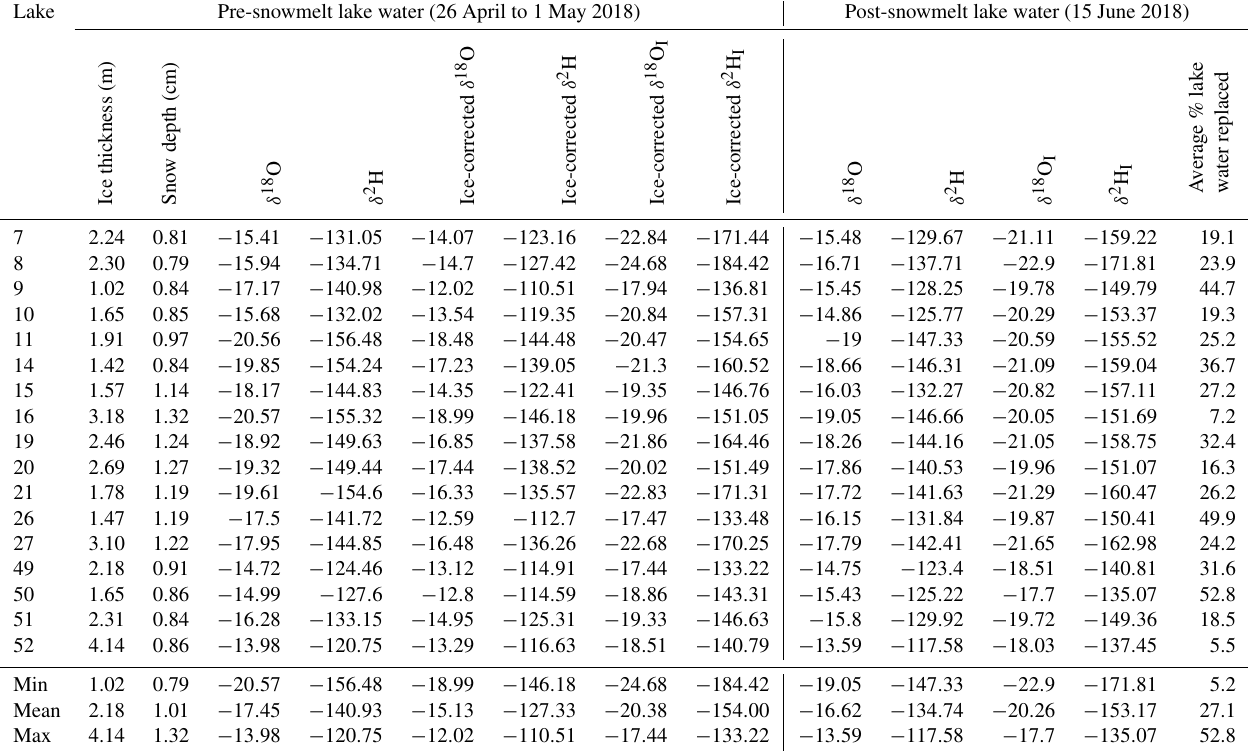
Table 2. Snow and ice thickness, isotope, δ I , and lake water replacement values for all lakes. Ice-corrected δ L values were used to calculate ice-corrected δ I values following Yi et al.